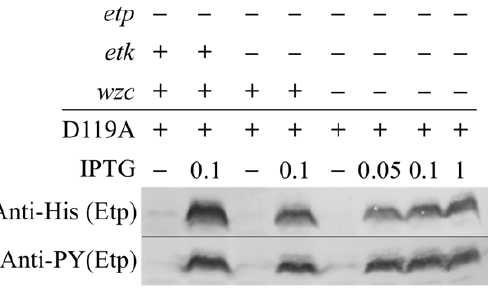
Figure 6. Etk and Wzc are not essential for Etp phosphoryla- tion. EtpD119A was expressed in different EPEC strains with deletions in the etp gene and the kinase genes etk and wzc . Proteins were extracted and the amount and phosphorylation state of Etp were tested by Western blot using anti-6His and anti-PY antibodies, respectively. The presence of intact genes is indicated above the lanes.